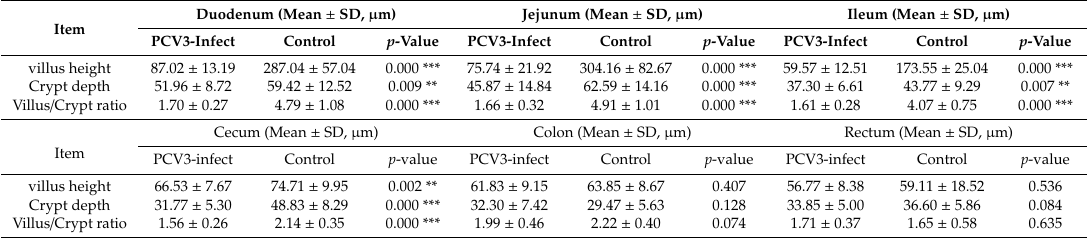
Figure 4. Histopathologic lesions of the small intestine induced by PCV3 strain JX/CH/2018 infection. Severe villous atrophy in the duodenum, jejunum, and ileum of the piglets under PCV3 infection are presented. Table 2. Mean villus height, crypt depth, and villus / crypt ratio in various intestinal sections of PCV3-infected and negative control